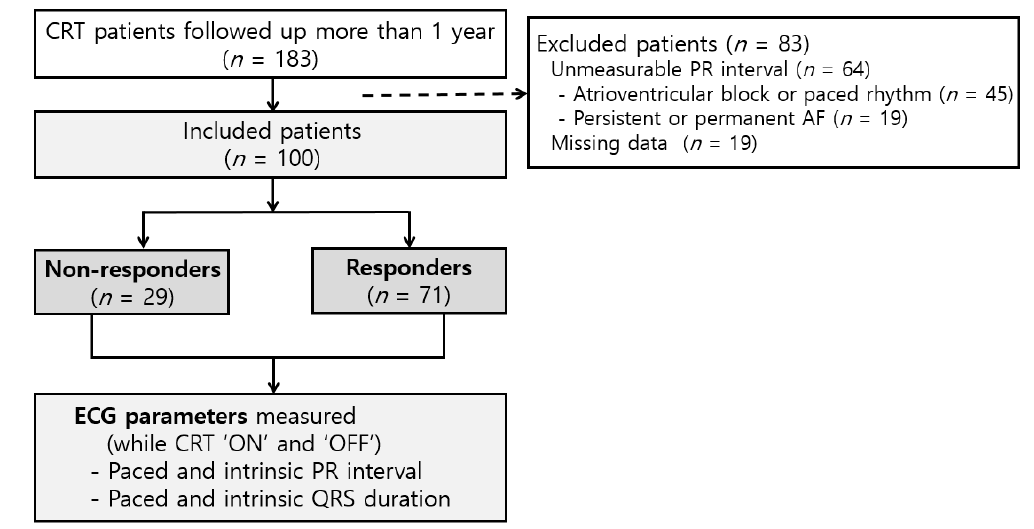
Figure 1. Flow chart of the study population. Table 1. Baseline